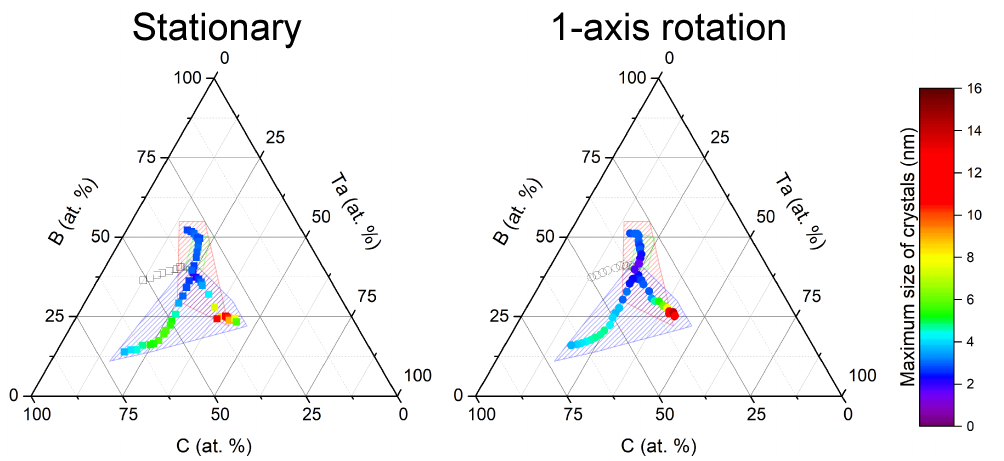
Figure 10. Maximum crystallite sizes calculated from the most intensive diffraction